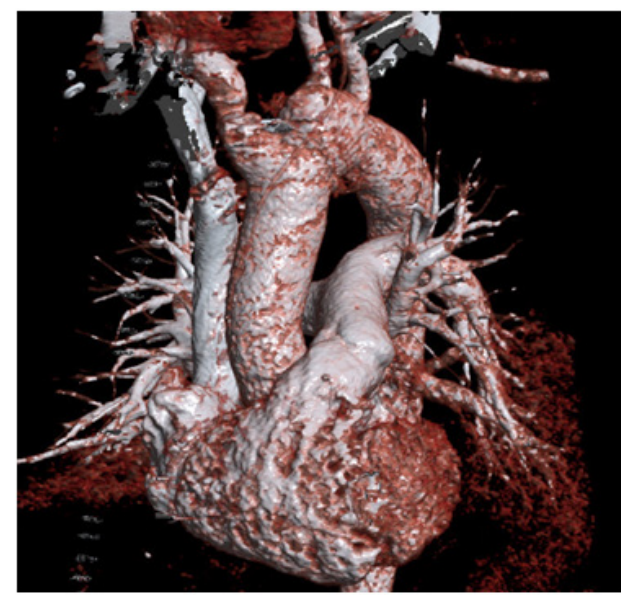
Fig. 3 – 3D reconstruction of postoperative CT showing the replacement of the ascending aorta and the re-implanted brachiocephalic